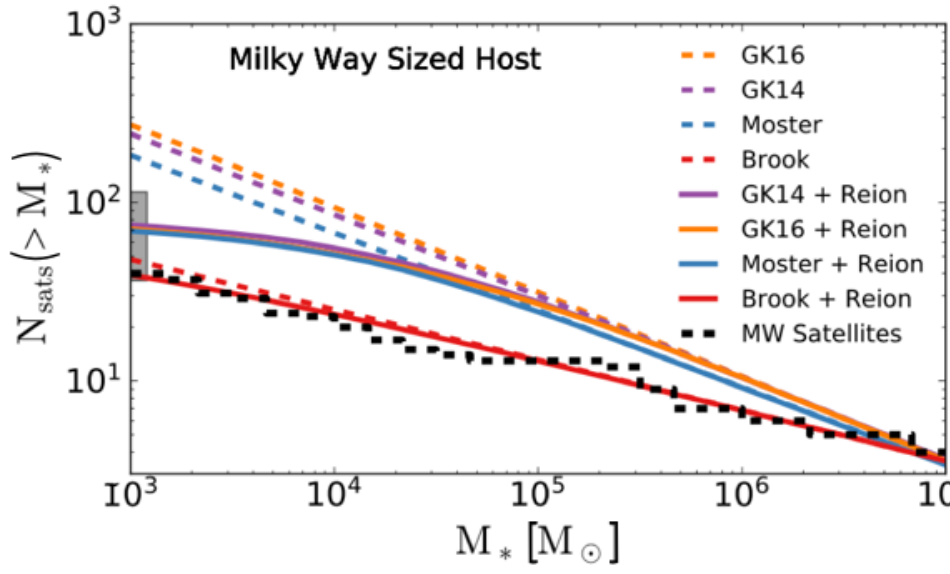
Figure 9. Mean number of satellite galaxies with mass larger than a given stellar mass threshold, N sats ( > M ∗ ) , as a function of the threshold mass, M ∗ , around a Milky Way-sized galaxy hosted by a dark-matter halo with virial mass M halo = 1.4 × 10 12 M (cid:12) , as predicted by various AM models applied to the dark-matter-only Caterpillar simulations. The colored dashed lines indicate the predictions of the AM models shown in Figure 8; the solid lines show the predictions of the same models after the inclusion of reionization that suppresses the formation of low-mass galaxies. The grey box represents the prediction of 37–114 satellites with stellar luminosity L ∗ > 10 3 L (cid:12) by [273], derived by combining several toy models applied to dark-matter-only simulations with the sample of dwarfs corrected for completeness, observed by the Sloan Digital Sky Survey. For comparison, the complementary cumulative stellar mass function (derived from V -band luminosities, assuming a mass-to-light ratio equal to 1 M (cid:12) /L (cid:12) ) of the 40 known satellite galaxies of the Milky Way with M ∗ > 10 3 M (cid:12) is shown with a black dashed line. The figure is reproduced from [272]. Here, we corrected the misprint that is present in the label of the ordinate axis of the original